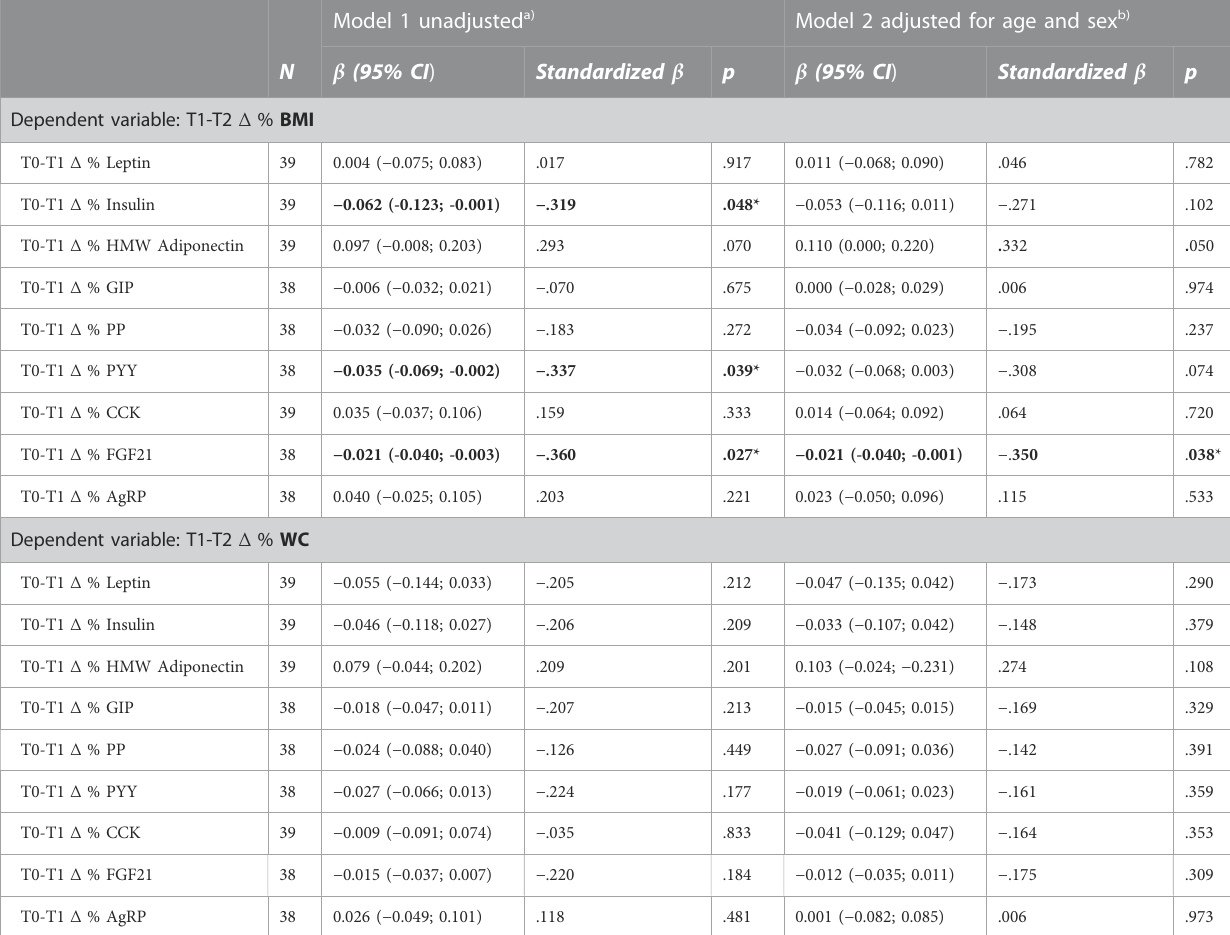
TABLE 3 Associations between initial (T0-T1) % changes in hormone levels and subsequent (T1-T2) % changes in